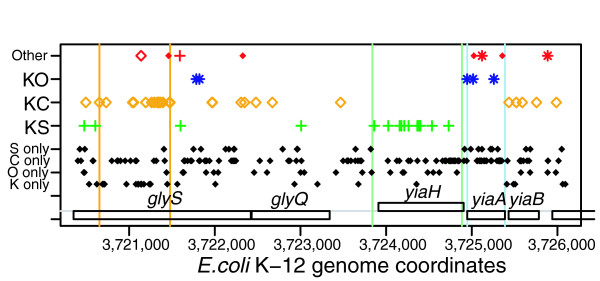
The location of all SNDs in a 5 kb region. In clusters demarcated by colored lines, note the corresponding absence of two more common types of SNDs. Three diamonds in lighter shades of blue, green, and red are compatible tri-partitions (see Additional data file 1). Colored lines demarcate regions where the absence of lineage-specific SNDs is offset by an increase in the corresponding recombinant pattern (for example, in yiaA, no K-12 or S. flexneri only SNDs).